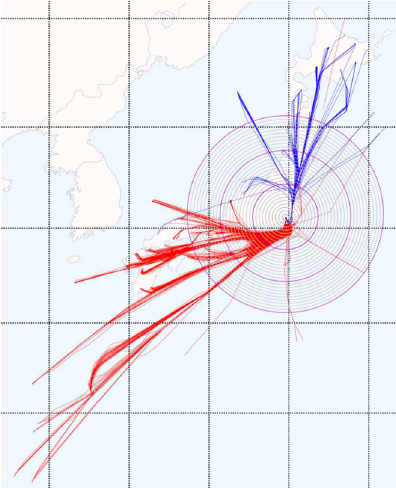
Figure 3. Example record of flight tracks during an entire day in November 2016. The red tracks indicate traffic flow from southwest. The blue tracks indicate traffic flow from the